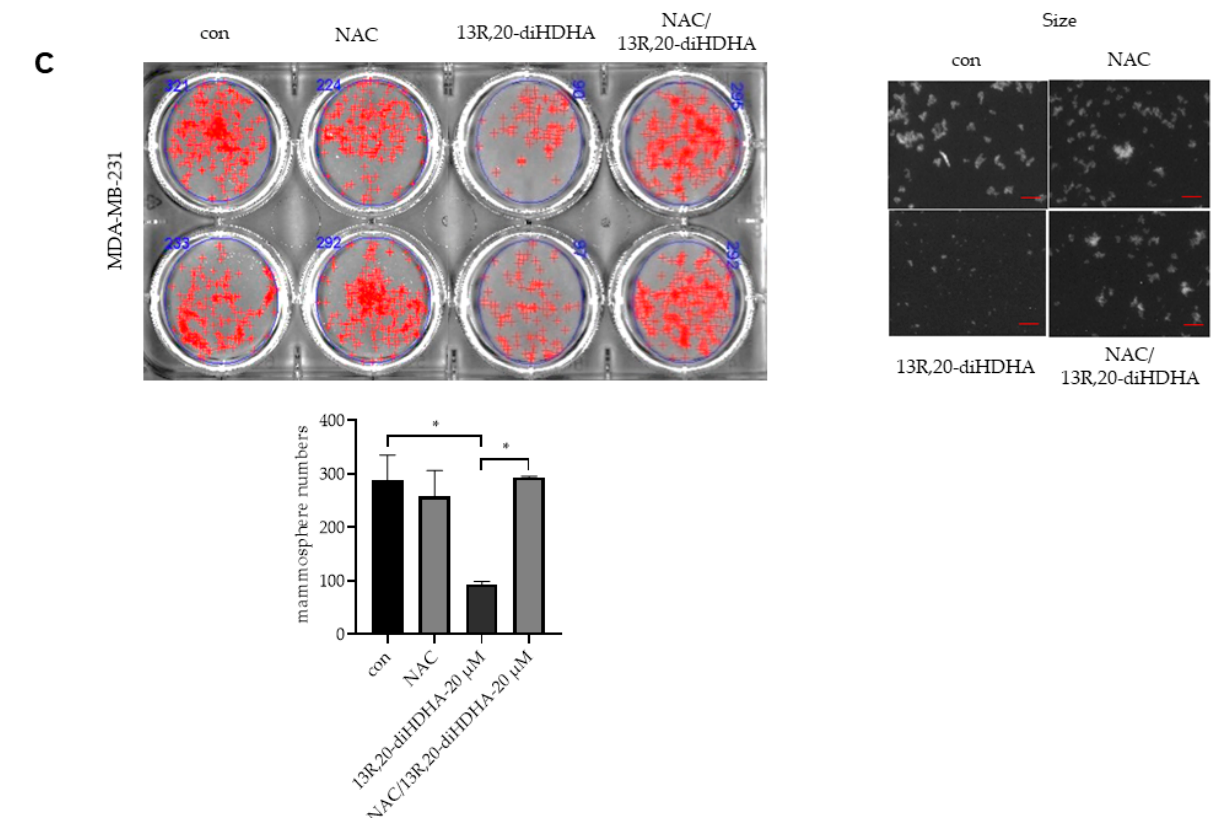
Figure 4. Effect of 13 R ,20-diHDHA-induced ROS generation on mammospheres formation. ( A , B ) The effect of 13 R ,20- diHDHA (20 μ M) on ROS generation in MDA-MB-231 and MCF-7 cells was determined using DCF-DA staining. Images were obtained by FACS and fluorescence microscopy at 4x magnification and representative photos are shown (scale bar: 100 μ m). ( C ) Mammospheres were pretreated with/without NAC (10 mM) for 1 h prior to treatment with 20 μ M 13 R ,20- diHDHA. After 7 days, mammospheres formation was determined. Representative images of colonies were recorded. The data from triplicate experiments are presented as the mean ± SD. * p < 0.05 versus the DMSO-treated control group.